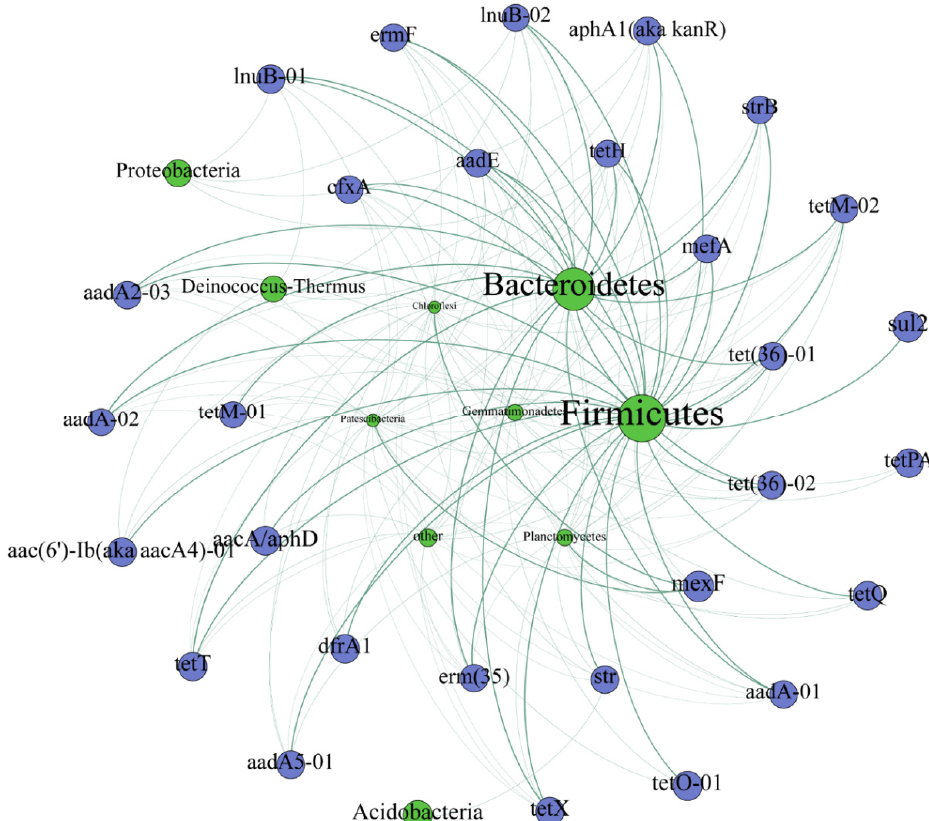
Figure 6. Network analysis between individual ARGs and bacteria community. The green and blue nodes represent the bacteria phyla and ARG subtype, respectively. A connection represents a strong correlation (Spearman’s correlation coefficient ρ ≥ 0.7 and significance level p < 0.01). The size of a node is proportional to the weighted degree, that is, the sum of the correlation coefficient of all connections related to this node.